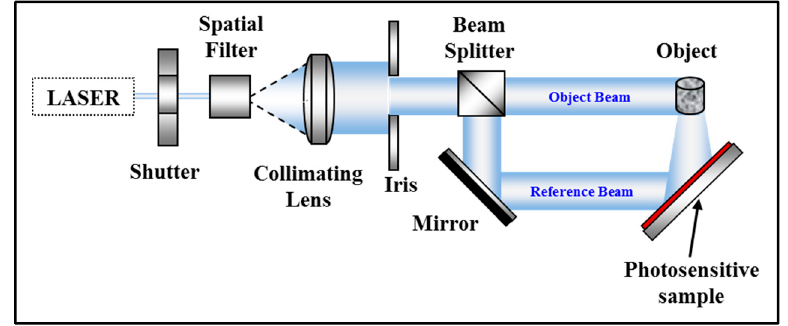
Figure 4. Basic set-up for recording an off axis transmission type hologram.